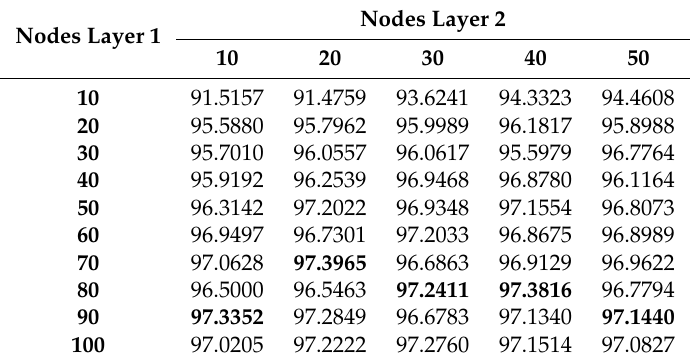
Table 4. Accuracy rate for a new RSS dataset, testing all the trained neural